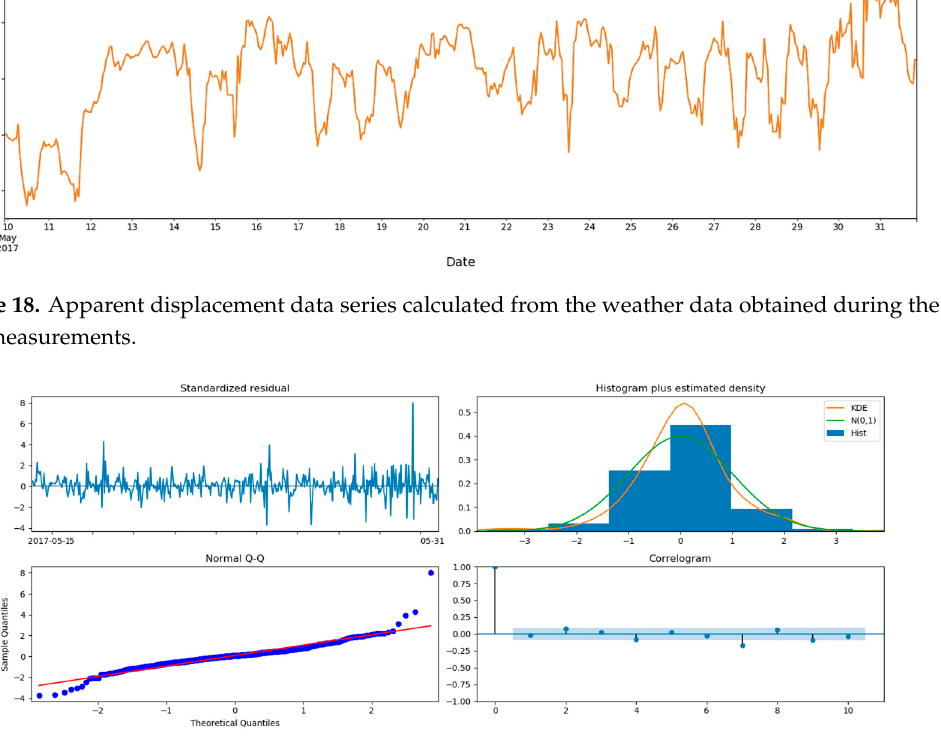
Figure 19. Diagnostic plots for the apparent displacement series obtained during the IBIS measurements for the SARIMAX (1, 0, 1) × (0, 1, 1) 24 model.